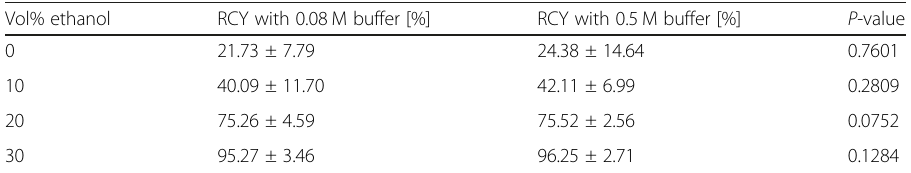
Table 1 Radiochemical yield compared from DOTA-TOC with 0.08 M buffer and 0.5 M buffer Vol%